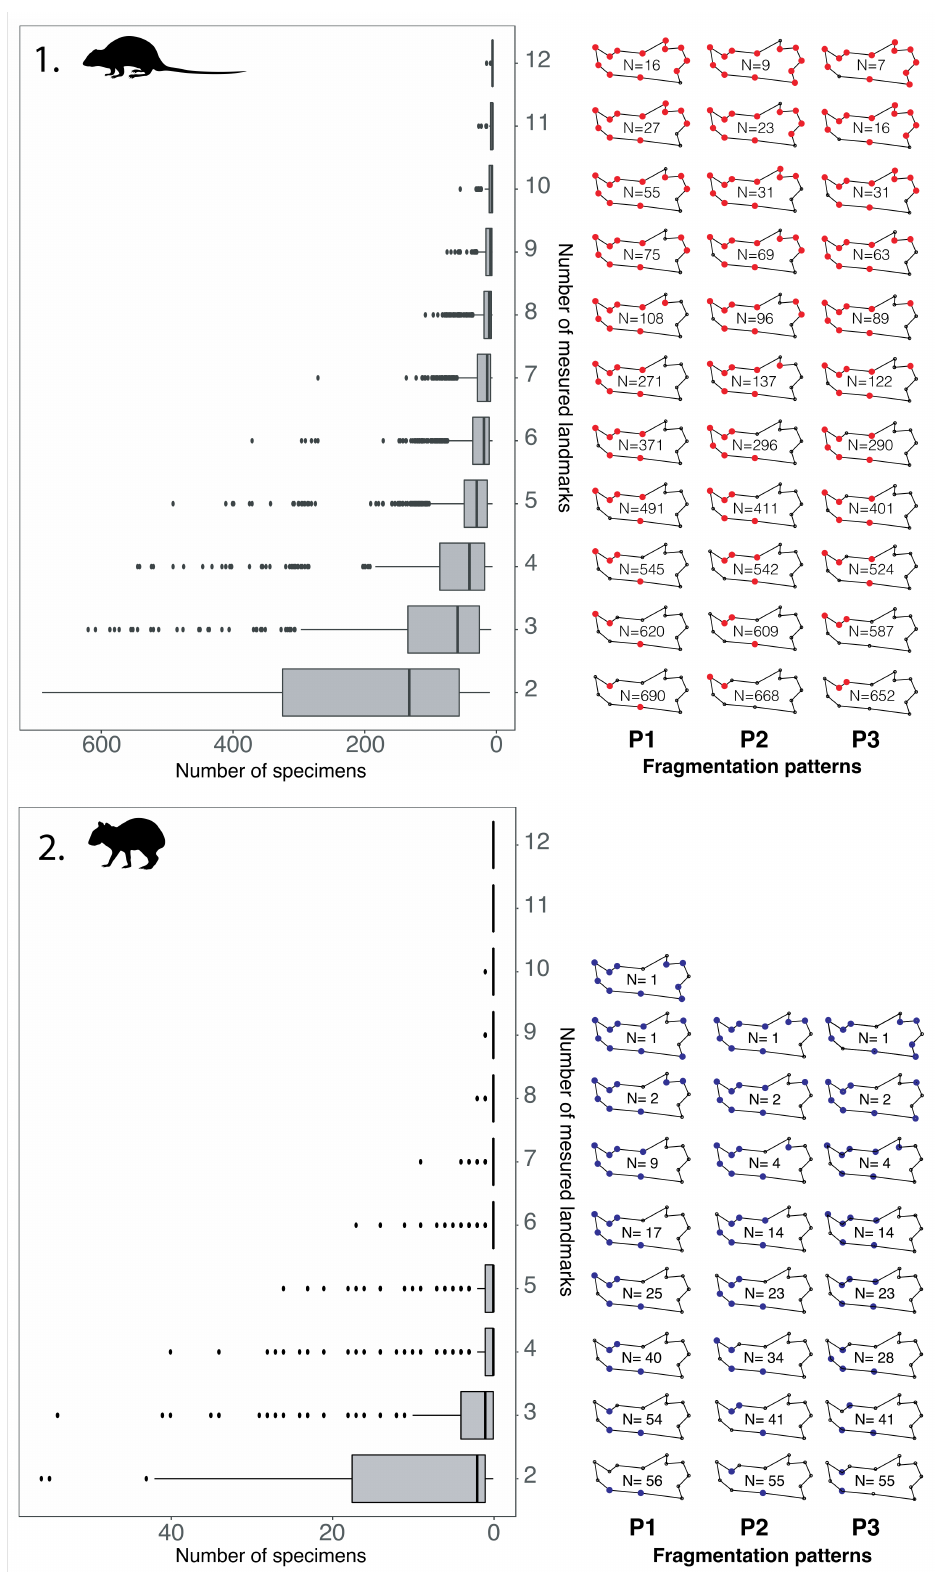
Figure 3. ( Left ) Number of fragmentation patterns for N landmarks on Oryzomyini ( 1 ) and Dasyprocta ( 2 ) mandibles, ( Right ) categories of the first three most frequent fragmentation patterns for N land- marks (P1, P2,